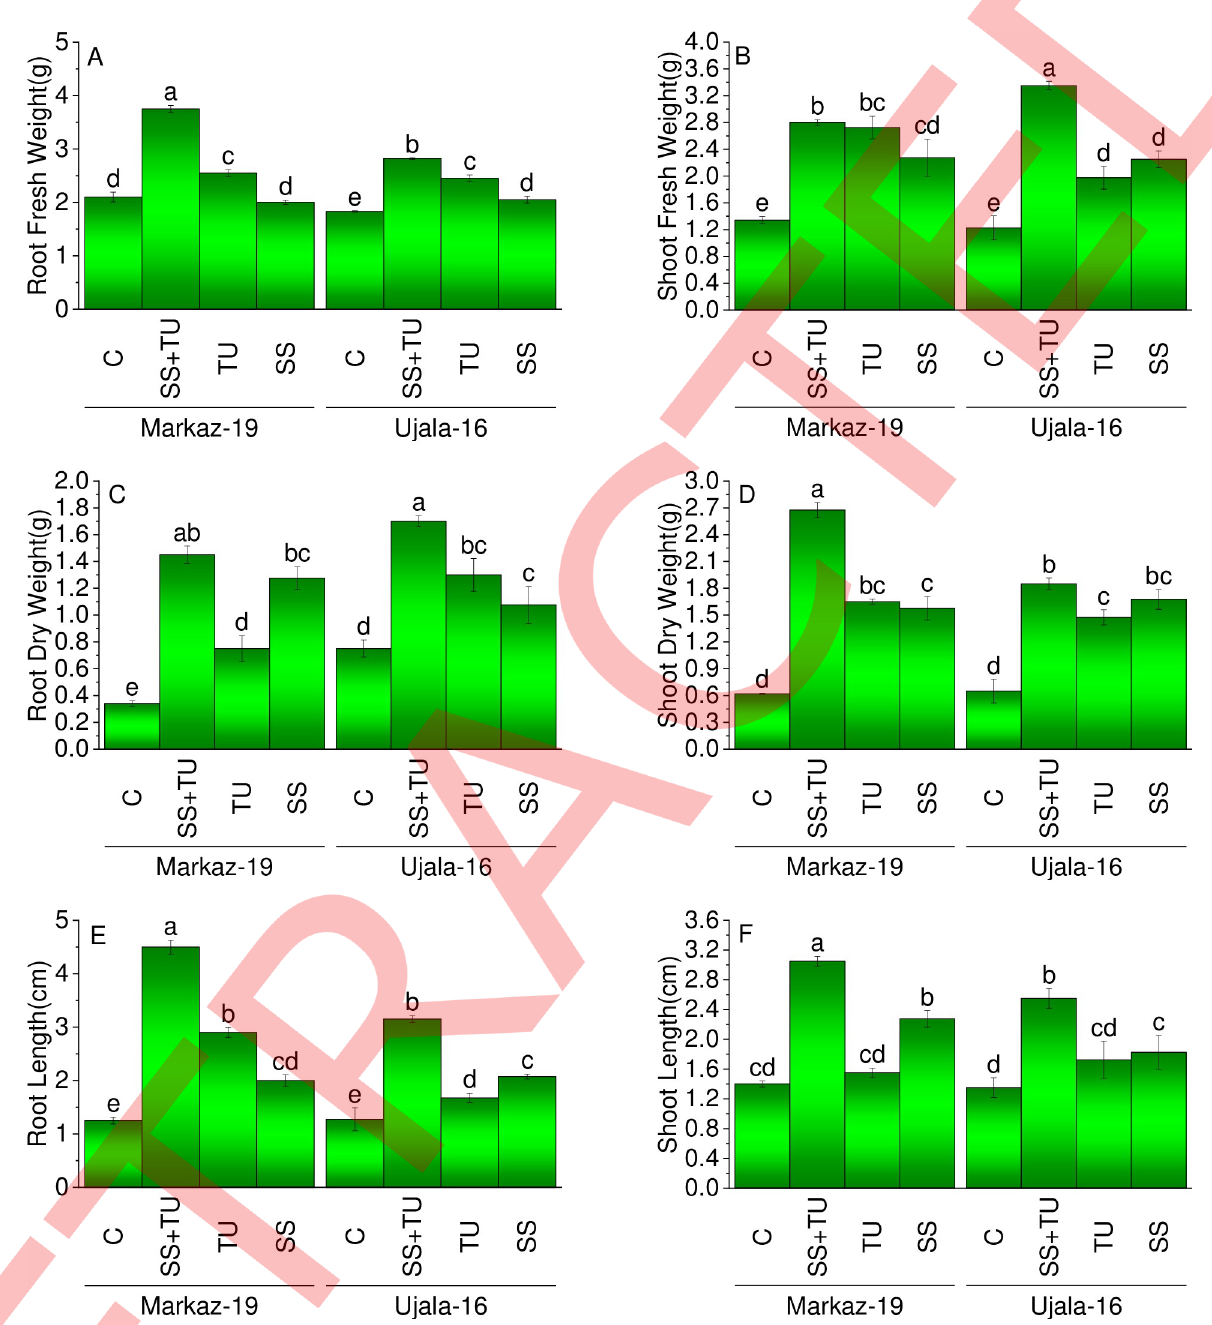
Fig 1. Impact of treatments on growth root fresh weight (A), shoot fresh weight (B), root dry weight (C), shoot dry weight (D), root length (E) and shoot length (F) of two wheat genotypes (Markaz 19 and Ujala 16) after 35 d of growth in pots. All values are the mean of 4 replicates. Error bars are showing ± standard error. Different letters on bars are significantly different at p < 0.05 according to LSD test. C: Control, SS+TU: sewage sludge +thiourea, TU: thiourea, SS: sewage sludge. for chlorophyll a, but significantly decreased total chlorophyll than control in Markaz 19. For chlorophyll b, all treatments remained non-significant over control in Markaz 19 and Ujala 16. For carotenoids, sole application, i.e., SS and TU remained non-significant over control in